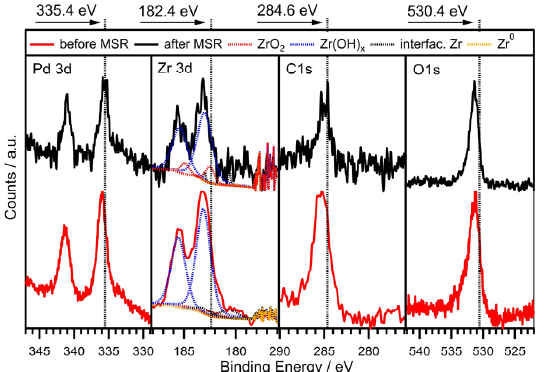
Figure 7. Ex situ XP spectra of the Pd-Zr system with nominal starting stoichiometry of Pd:Zr = 2:1 before and after the MSR reaction up to 873 K (reaction details cf. Figure 6). The Pd 3d, Zr 3d, C 1s and O 1s signals are shown in separate panels.